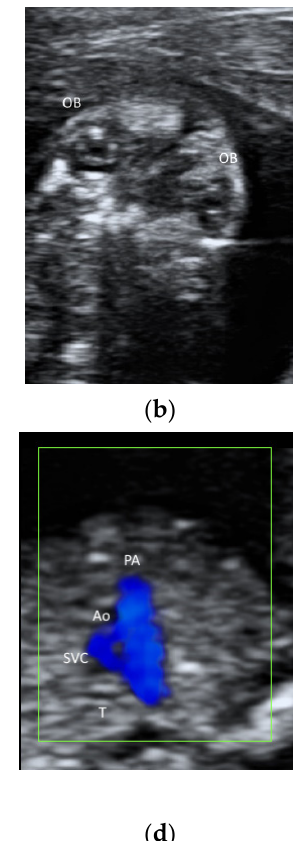
Figure 6. Ultrasonography of a fetus at 13 weeks’ gestation by a transabdominal high-frequency linear transducer: ( a ) transverse view of fetal brain, ( b ) coronal view of face showing both orbits (OB), ( c ) coronal view of abdomen showing both kidneys (Ki) on either side of the spine, and ( d ) the three-vessel trachea transverse view with color Doppler showing pulmonary artery (PA), aorta (Ao), superior vena cava (SVC), and trachea (T) .